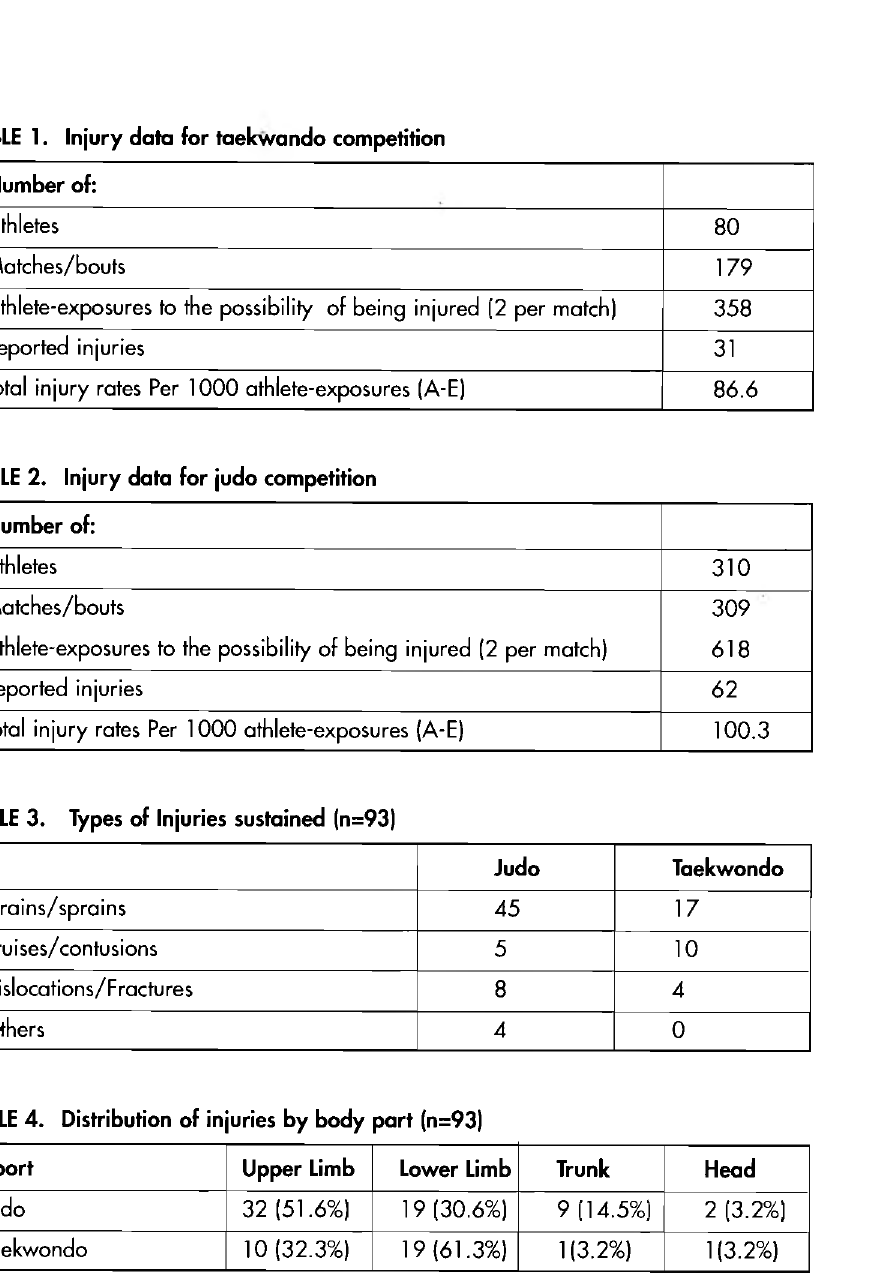
TABLE 1. Injury data for taekwando competition